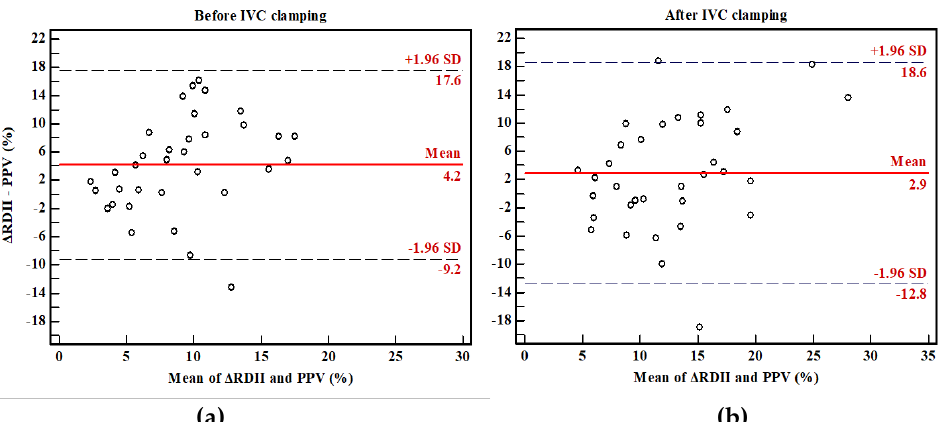
Figure 3. Bland – Altman analyses comparing variation of R- wave amplitude in lead II (ΔRDII) and Figure 3. Bland–Altman analyses comparing variation of R-wave amplitude in lead II ( ∆ RDII) and pulse pressure variation (PPV) during before ( a ) and after ( b ) inferior vena cava (IVC) clamping. The pulse pressure variation (PPV) during before ( a ) and after ( b ) IVC clamping. The dotted lines represent the average di ff erence between ∆ RDII and PPV (i.e., bias) and the solid lines represent the upper and dotted lines represent the average difference between ΔRDII and PPV (i.e., bias) and the solid lines lower 95% confidence limits of agreement. represent the upper and lower 95% confidence limits of agreement.